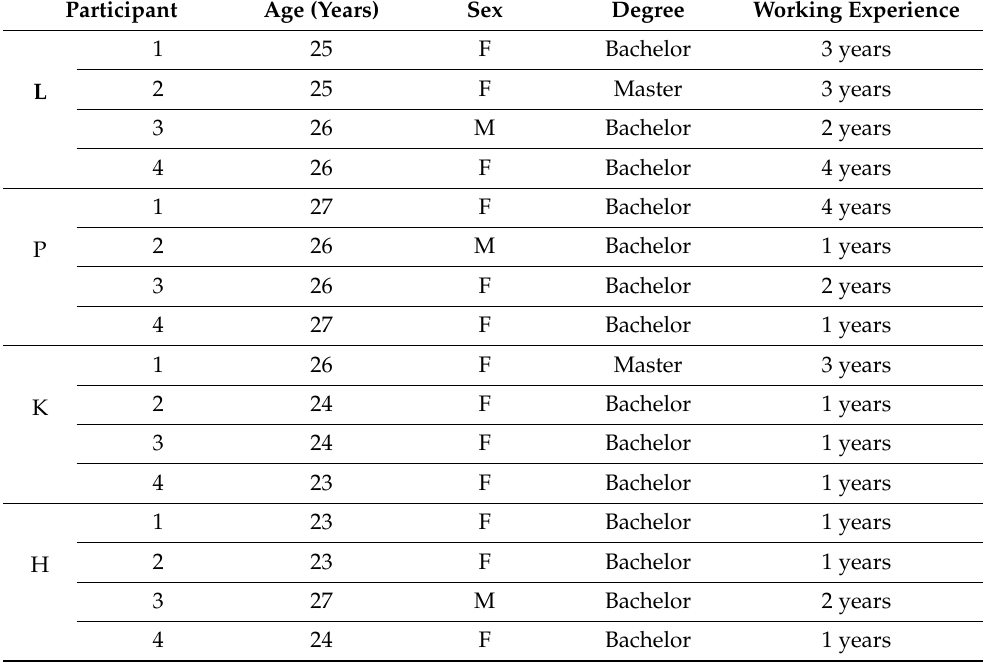
Table 1. General characteristics of study participants (N =